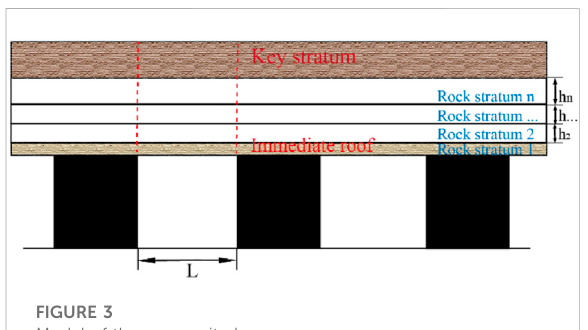
FIGURE 3 Model of the composite beams.